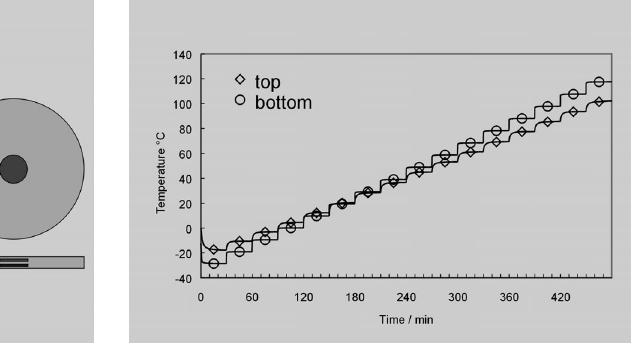
Figure 3 (left): Sensor tools for the design and evaluation of the new Advanced Peltier System PTD 150 (see text). Figure 4 (right): Temperature gradients with a conventional Peltier system with a passive cover. Huge temperature gradients up to 15 K